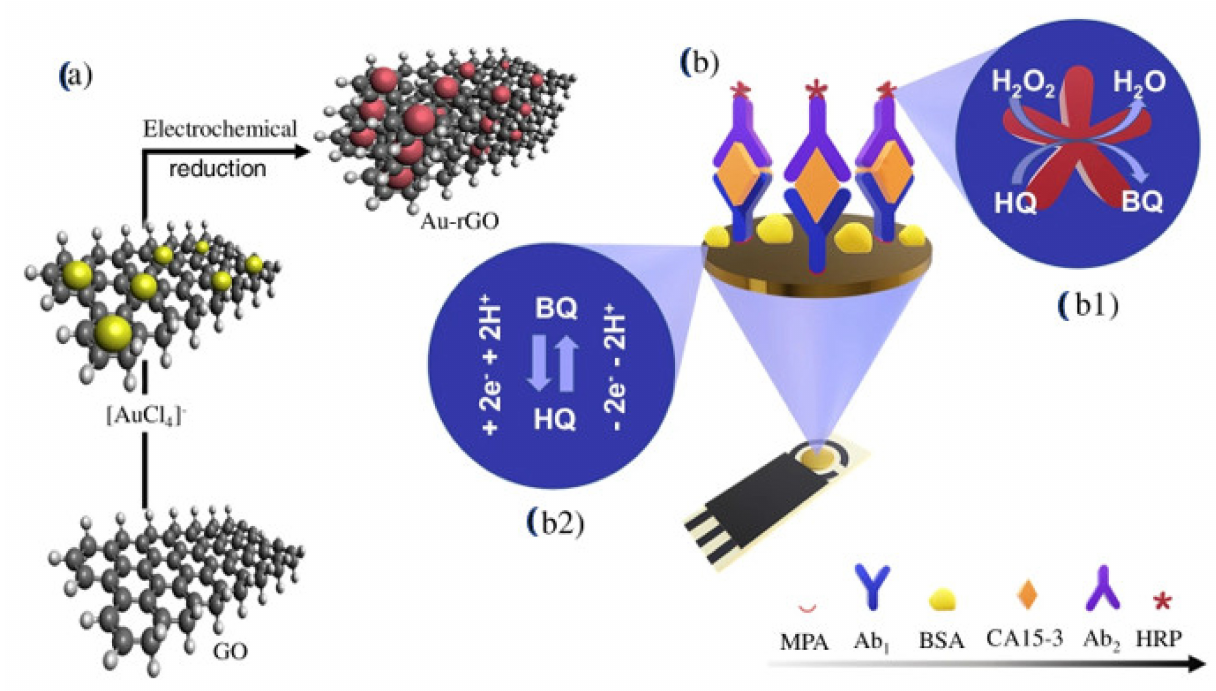
Figure 18. Illustration of the preparation of the electrochemical sandwich–type immunosensor using HRP enzyme for CA15–3 detection. ( a ): preparation process of Au nanoparticles and reduced graphene oxide (Au − rGO) nanocomposite through electrochemical reduction; ( b ): fabrication of the sensor; ( b1 ): reduction of H 2 O 2 by horseradish peroxidase (HRP), using hydroquinone (HQ) as electron mediator: ( b2 ): redox process. Reprinted with permission from [120], published by Springer–Verlag GmbH Austria,